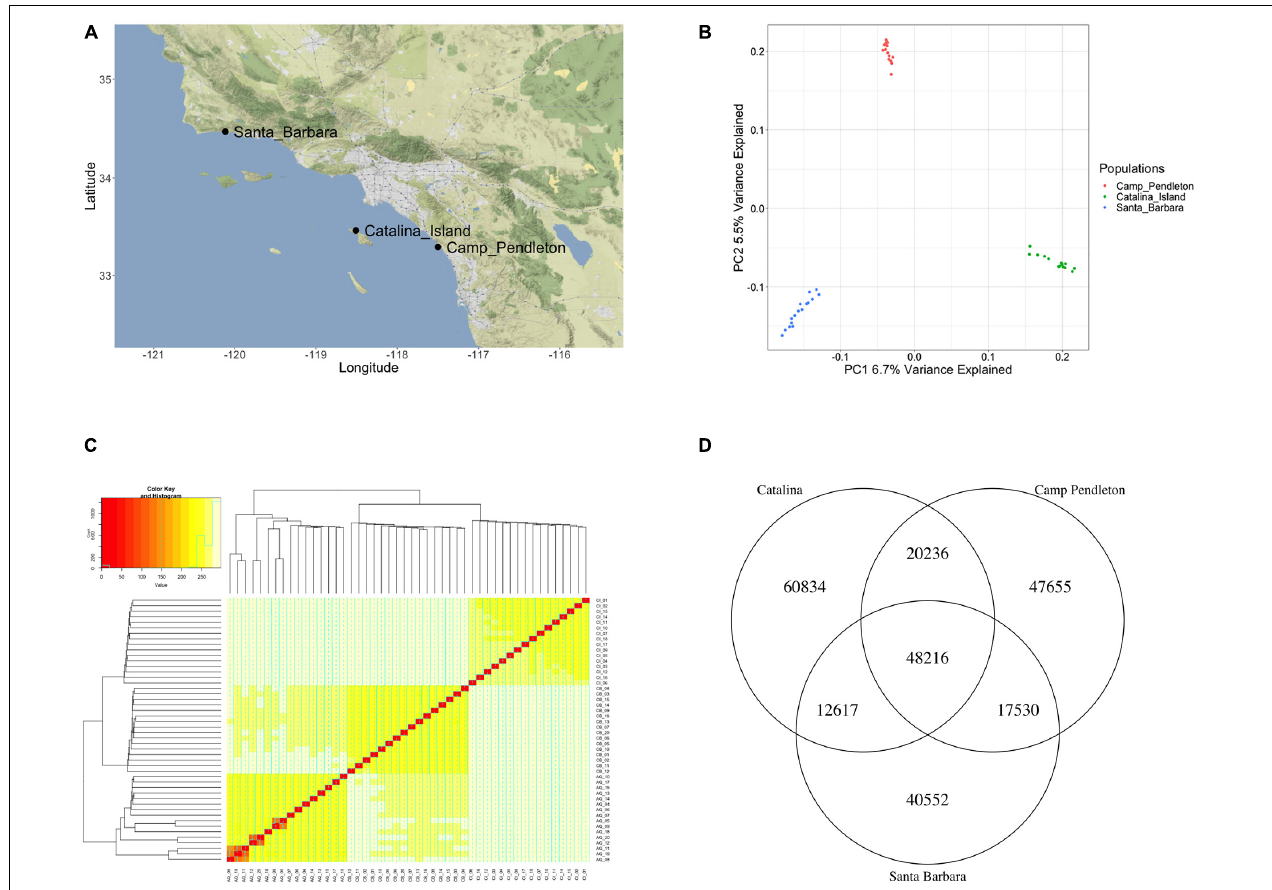
FIGURE 3 | Analysis of population structure between the three analyzed populations: (A) Sampling locations of wild kelp populations in Southern California. (B) Principal component analysis showing strong signs of population structure. (C) Nei’s genetic distance between 48 individuals mapped onto the gene models again showing clear population structure (AQ prefix is the Santa Barbara Population, CB prefix is the Camp Pendleton population). (D) Venn diagram of single nucleotide polymorphism (SNPs) presented in each population showing that most SNPs are population